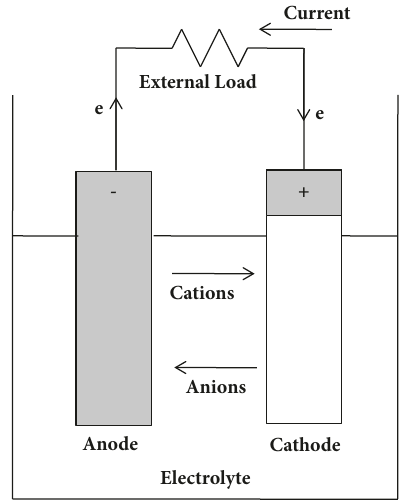
Figure 1: Diagram of the simplest electrochemical cell.